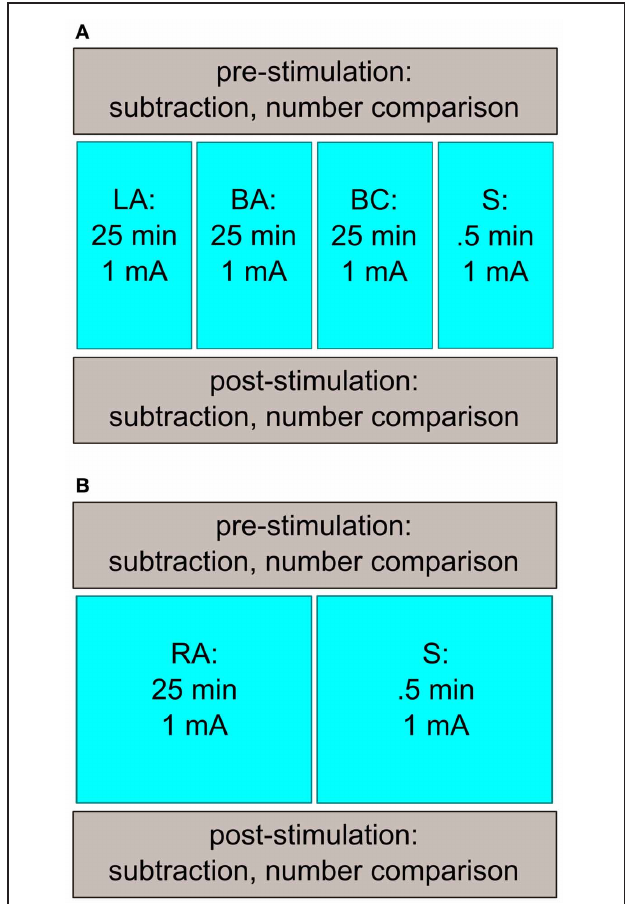
FIGURE 1 | Study design of Experiments 1 and 2. (A) Subjects came in for four sessions. Before and after stimulation, the participants performed a number comparison and a subtraction task. The stimulation conditions (LA, BA, BC, S) were counter-balanced across sessions. (B) A similar study design as in Experiment 1 was used in the second experiment. The participants had to attend twice, where they received either RA or S